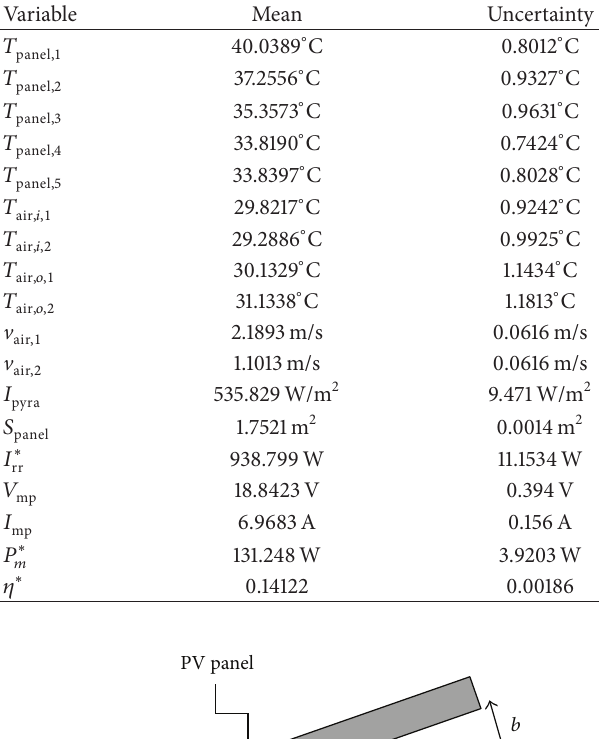
Table 2: Mean values and uncertainty calculated from the uncer- tainty propagation law [13] for the panel variables.